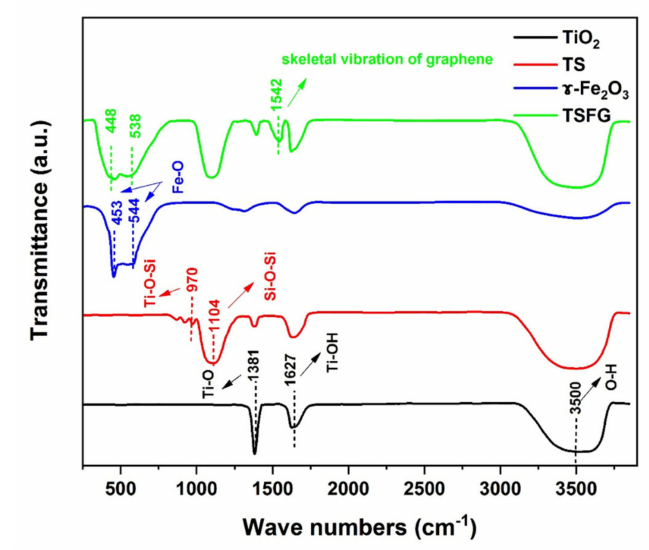
Figure 5. FTIR spectra of TiO 2 , TS, γ -Fe 2 O 3 , and TSFG samples for wave numbers ranging from 300 to 4000 cm − 1 .